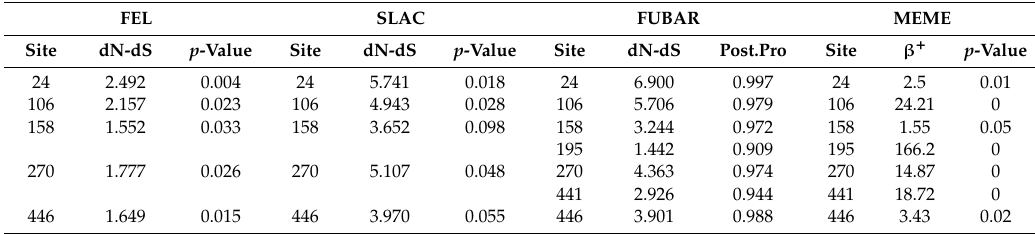
Table 1. Selection analysis of PPV7 Cap coding sequences.